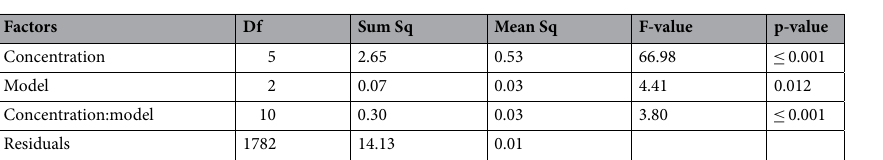
Table 1. The analysis of variance results indicating the significance of concentrations, models and their interactions for explaining the variation in RMSE over test data is presented.